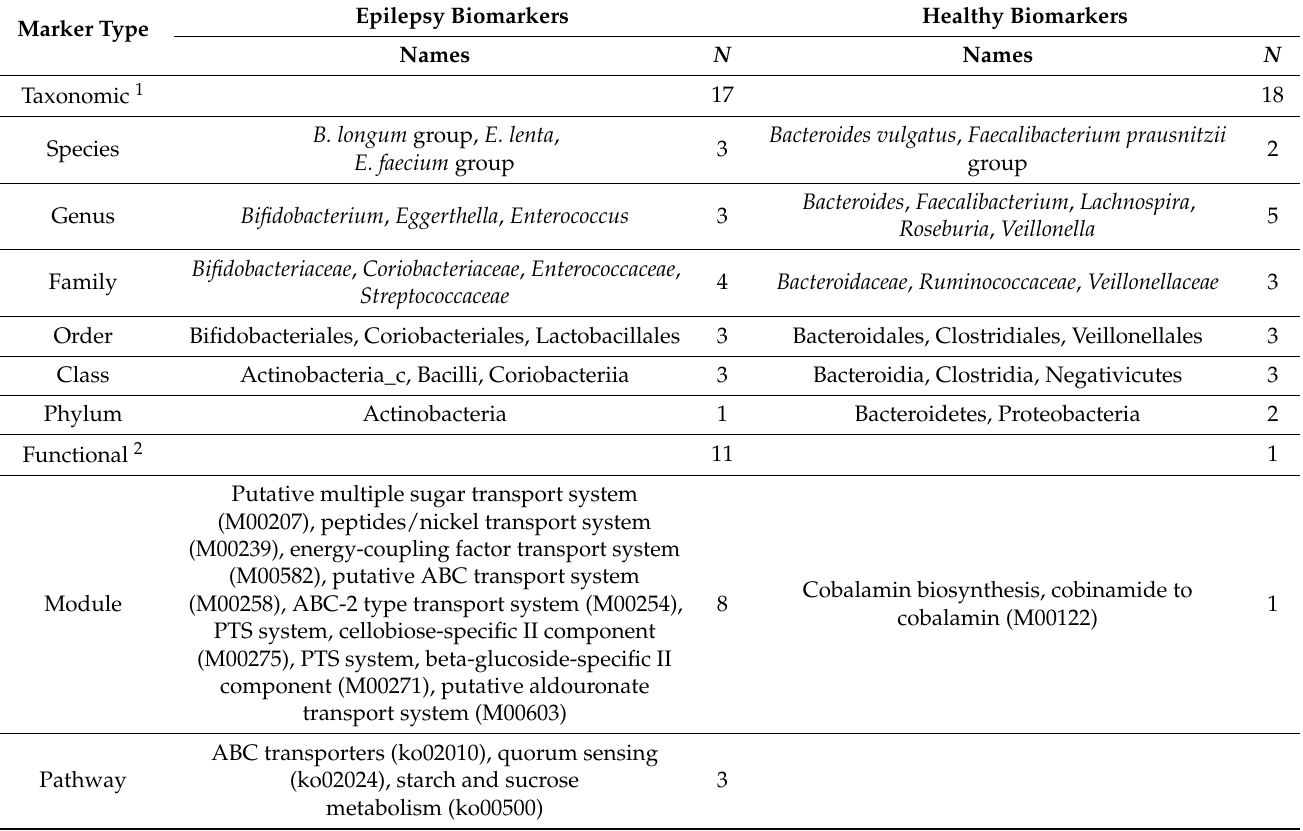
Table 4. Comparison between the clinical data of the epilepsy and control